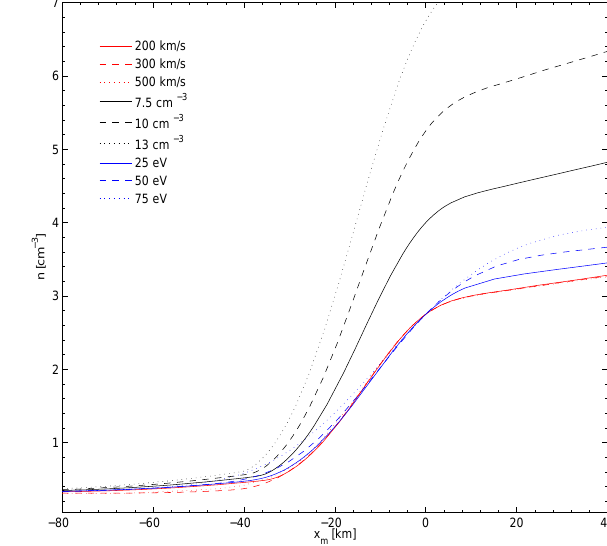
Fig. 3. Detail on the very central region of the magnetospheric po- tential profile, 8 m (x m ) , derived for TD solutions obtained for vari- ous boundary conditions: three LLBL bulk velocities (red profiles), three LLBL densities (black profiles), three LLBL electron temper- atures (blue profiles). See caption of Fig. 2 for explanation of colors and reference values of parameters.